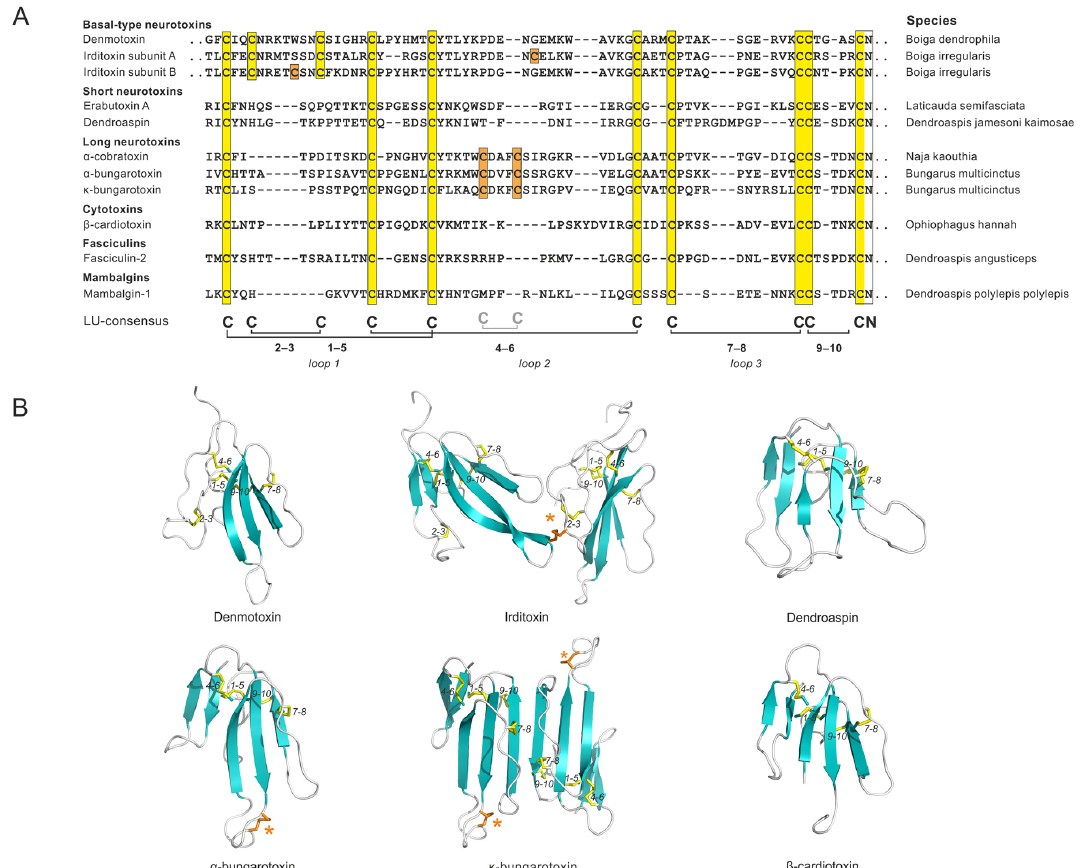
Figure 2. Evolution and neo-functionalization of LU domains from snake venom toxins: ( A ) A sequence alignment of typical members of the di ff erent groups of snake-venom toxins. Note, only the basal-type neurotoxins maintain the 2–3 disulfide bond. Orange boxes highlight apotypic cysteine residues and yellow boxes highlight plesiotypic LU-domain cysteine residues. Dots indicate sequence extensions. The apotypic, intra-domain disulfide bond in the long-chain α -neurotoxins is included in the